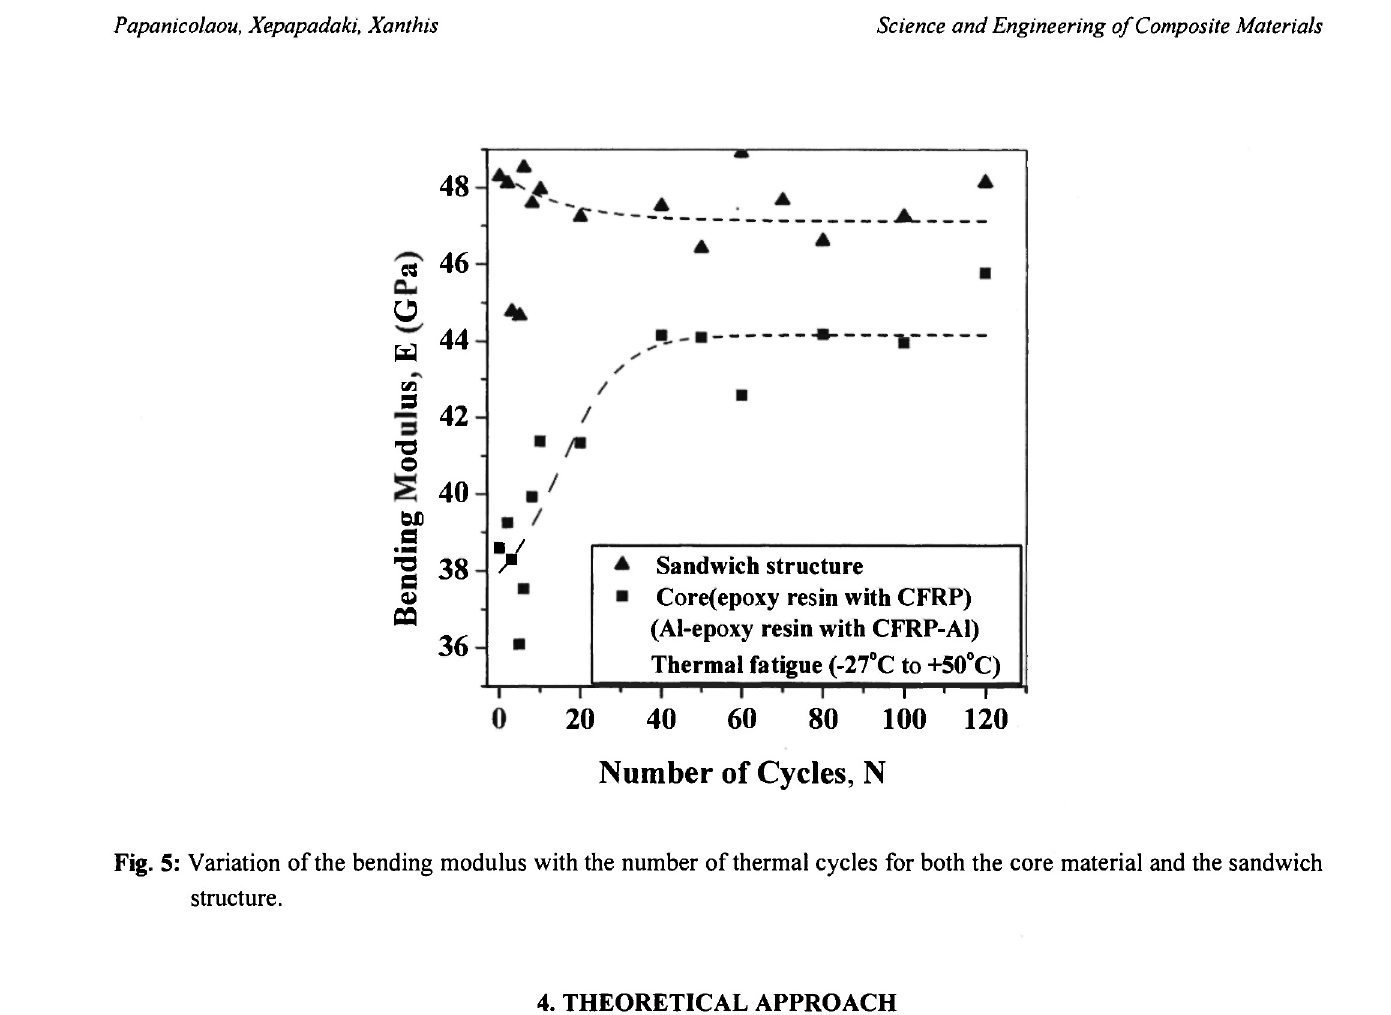
Fig. 5: Variation of the bending modulus with the number of thermal cycles for both the core material and the sandwich